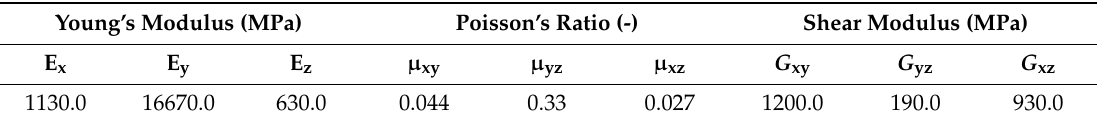
Table 1. Material constants for laminated beech lamellae, y direction is along the grain [85].